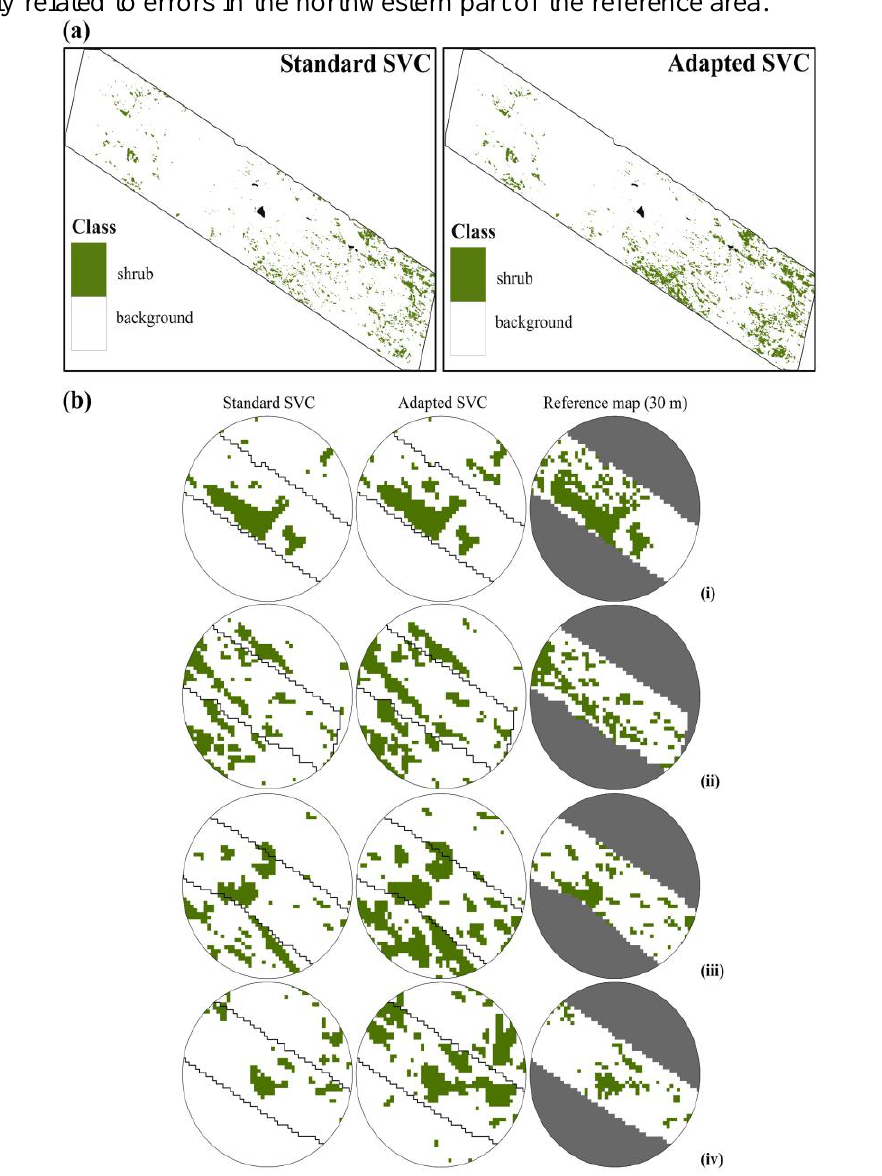
Figure 3. Discrete shrub cover maps derived from standard SVC and adapted SVC ( a ) for the entire study area and ( b ) for selected subsets. For information on coordinates and orientation, the reader is referred to Figure